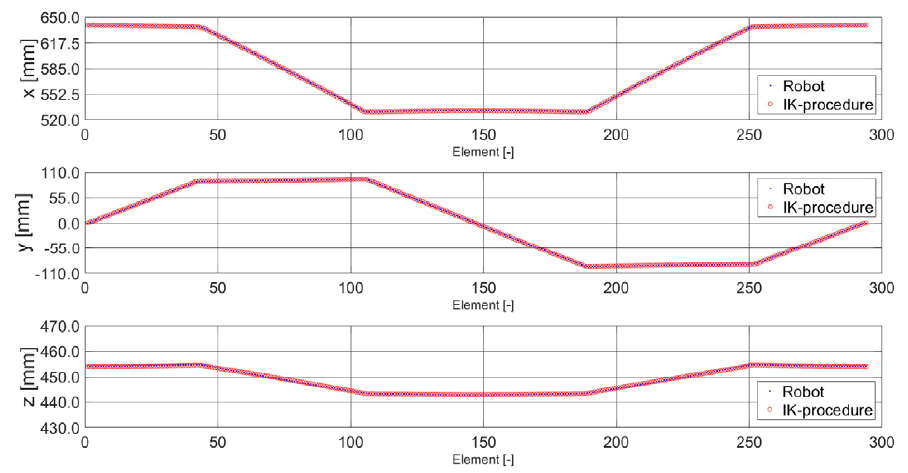
Figure 16. Rectangle in the X-Y plane: X-, Y-, Z-axes Robot vs. IK procedure.